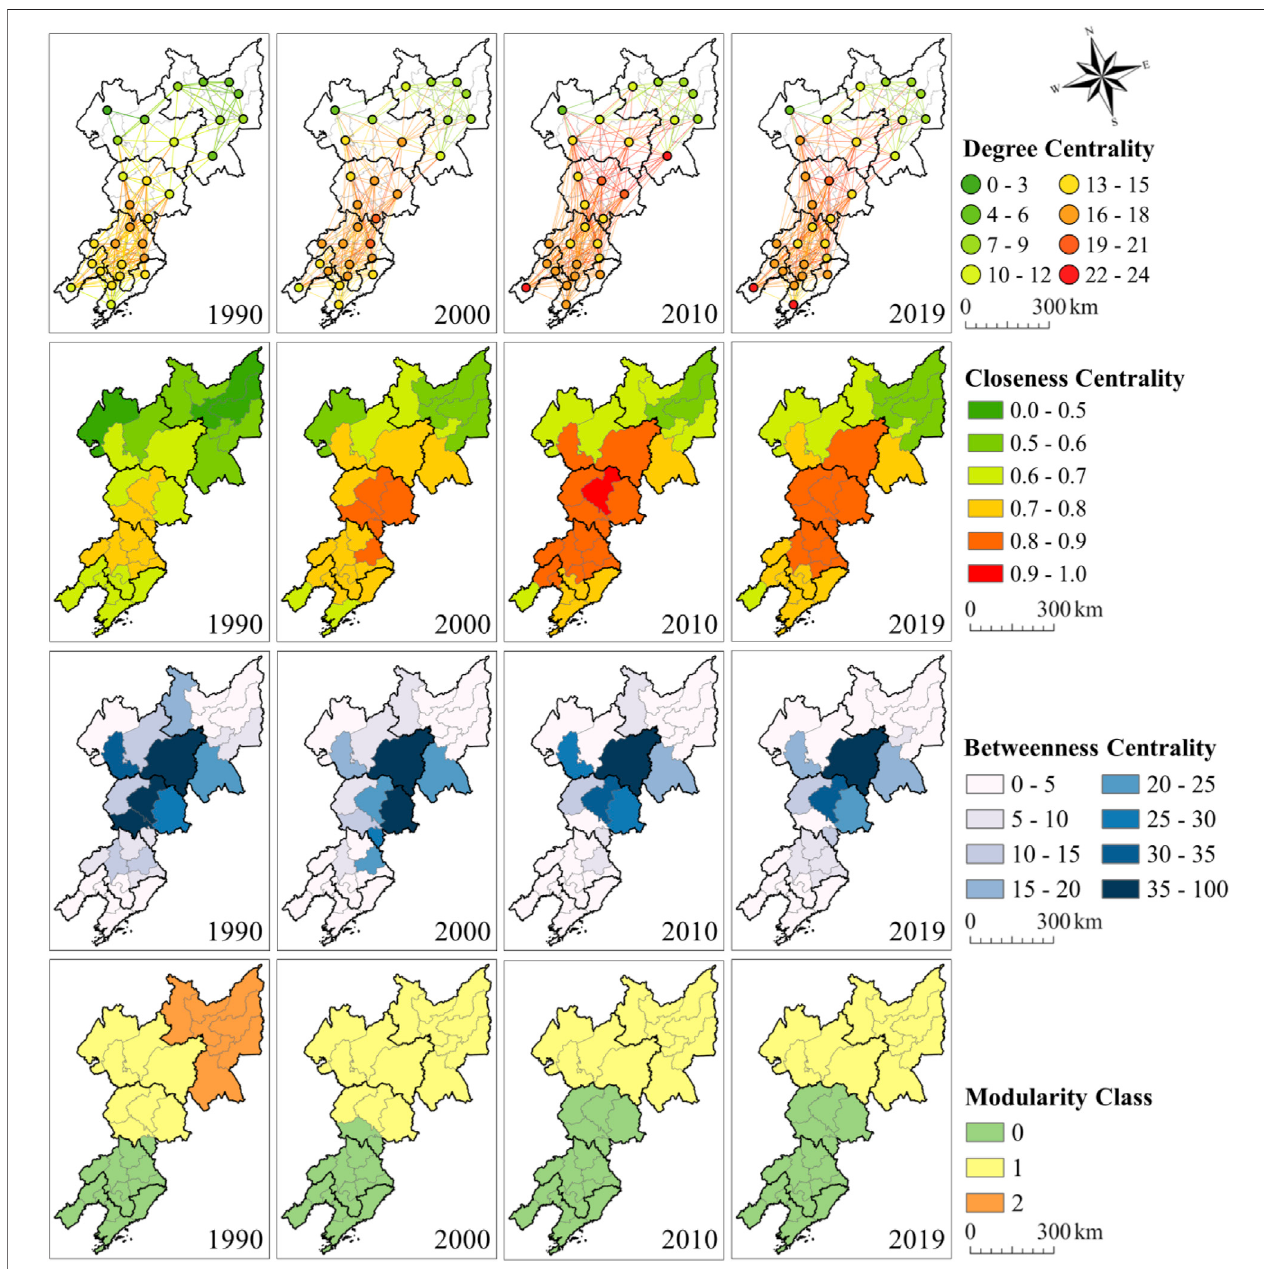
FIGURE 6 | Relevance network structure